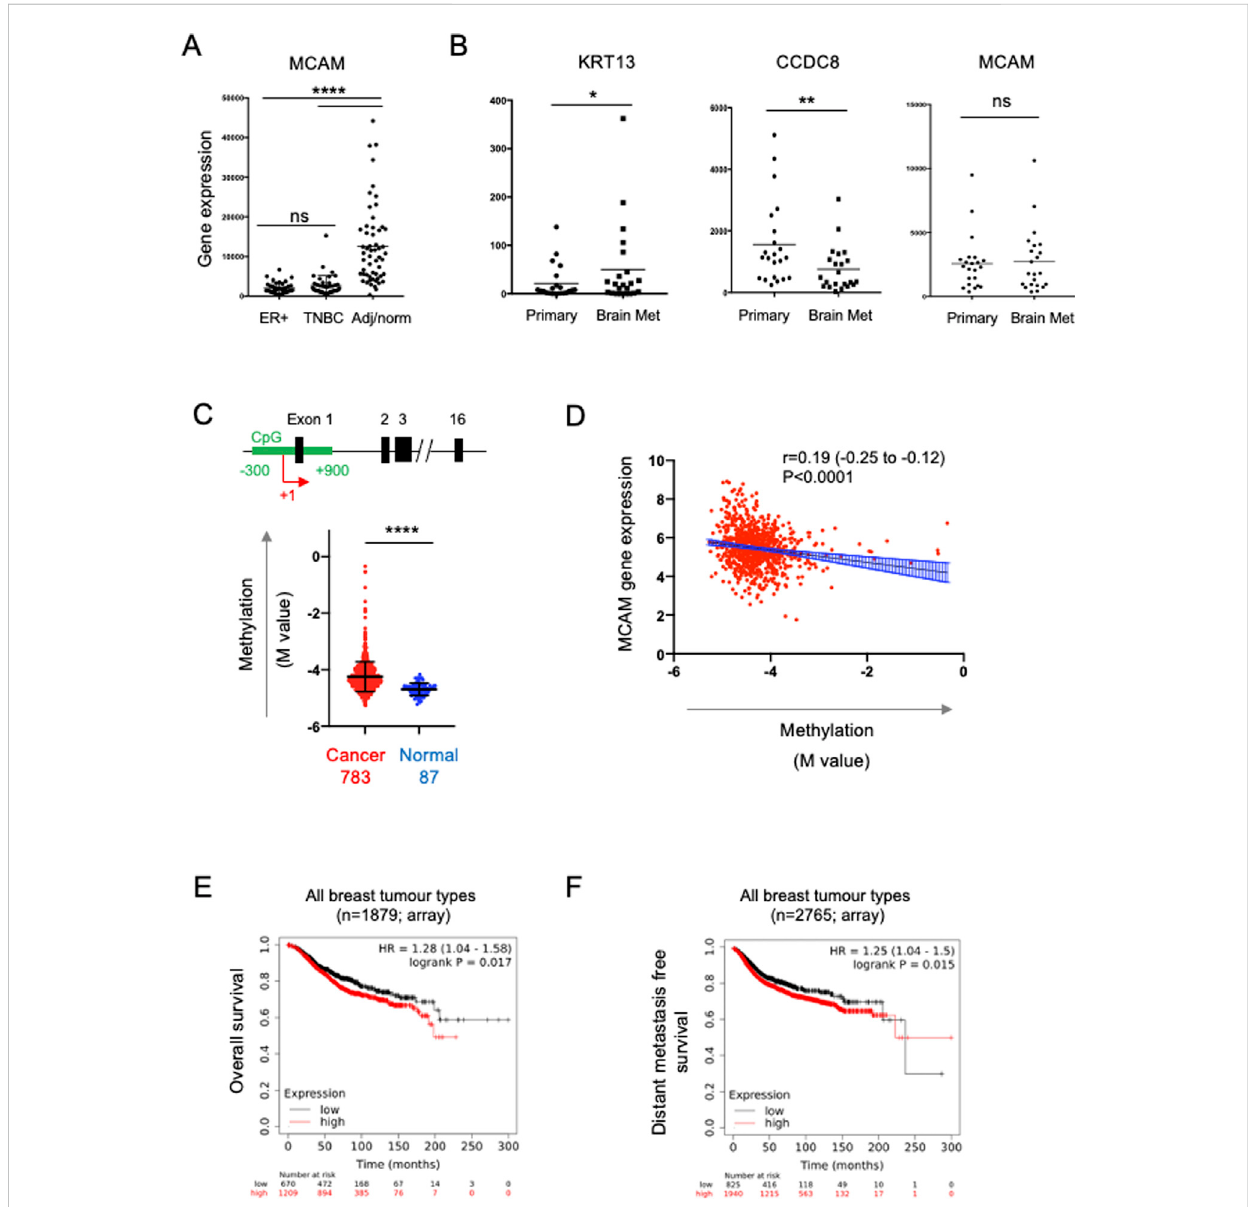
FIGURE 5 Expression of the MCAM gene in breast cancer. (A) MCAM gene expression in ER + breast tumours ( n = 42), TNBC tumours ( n = 42), as well as adjacent/normal breast tissue ( n = 56). Expression values were obtained from the data of Varley et al. (2014). Differences in expression between the pairs ofsamplesindicatedwasanalysedusingatwo-tailedMann-Whitneytest;**** p < 0.0001ornotsigni fi cant(ns).FurtheranalysisofthesesamplesforESR1, PGR, ERBB2 and EPCAM gene expression is shown in Supplementary Figure S1. (B) Expression of KRT13, CCDC8 and MCAM genes in 26 primary breast cancers and patient matched brain metastases; expression values were obtained from the data of Vare š lija et al. (2019). Differences in expression between these samples was analysed using a two-tailed Wilcoxon matched-pairs signed rank test; * p < 0.05, ** p < 0.01 or not signi fi cant (ns). (C) Methylation of aCpG island around thetranscriptional start site (TSS; +1) of the MCAM gene. The diagram shows a representation of theMCAMgene, indicating the position of the CpG island (in green) relative to the exons (black) and the TSS (+1, red arrow). The graph shows the methylation (M value) in breast cancer and normal tissue samples (793 and 87 samples respectively, from TCGA) using data from nine probes across the CpG island. For each sample, we calculated the mean M value and compared these values in the tumour and normal tissue using a two-tailed Mann Whitney test; **** p < 0.0001. Data analysis and download was performed using SMART (Li et al., 2019). Methylation data for individual probes within the CpG island are shown inSupplementaryFigureS2. (D) CorrelationofMCAMmethylationwithMCAMgeneexpression(usingTCGAdataanalysed via SMART).Spearman ’ sr,95% con fi dence internals (and associated p -value) are shown together with the linear regression line and con fi dence intervals. (E) Kaplan-Meier analysis of overall survivalinacohortof1879 breastcancerpatientsstrati fi edfor MCAM geneexpression. (F) Kaplan-Meier analysis ofdistant metastasis freesurvival in a cohort of 2,765 patients containing all breast cancer types, strati fi ed for MCAM gene expression. For (E,F) , data was graphed and analysed and using KM plotter (Györffy et al.,